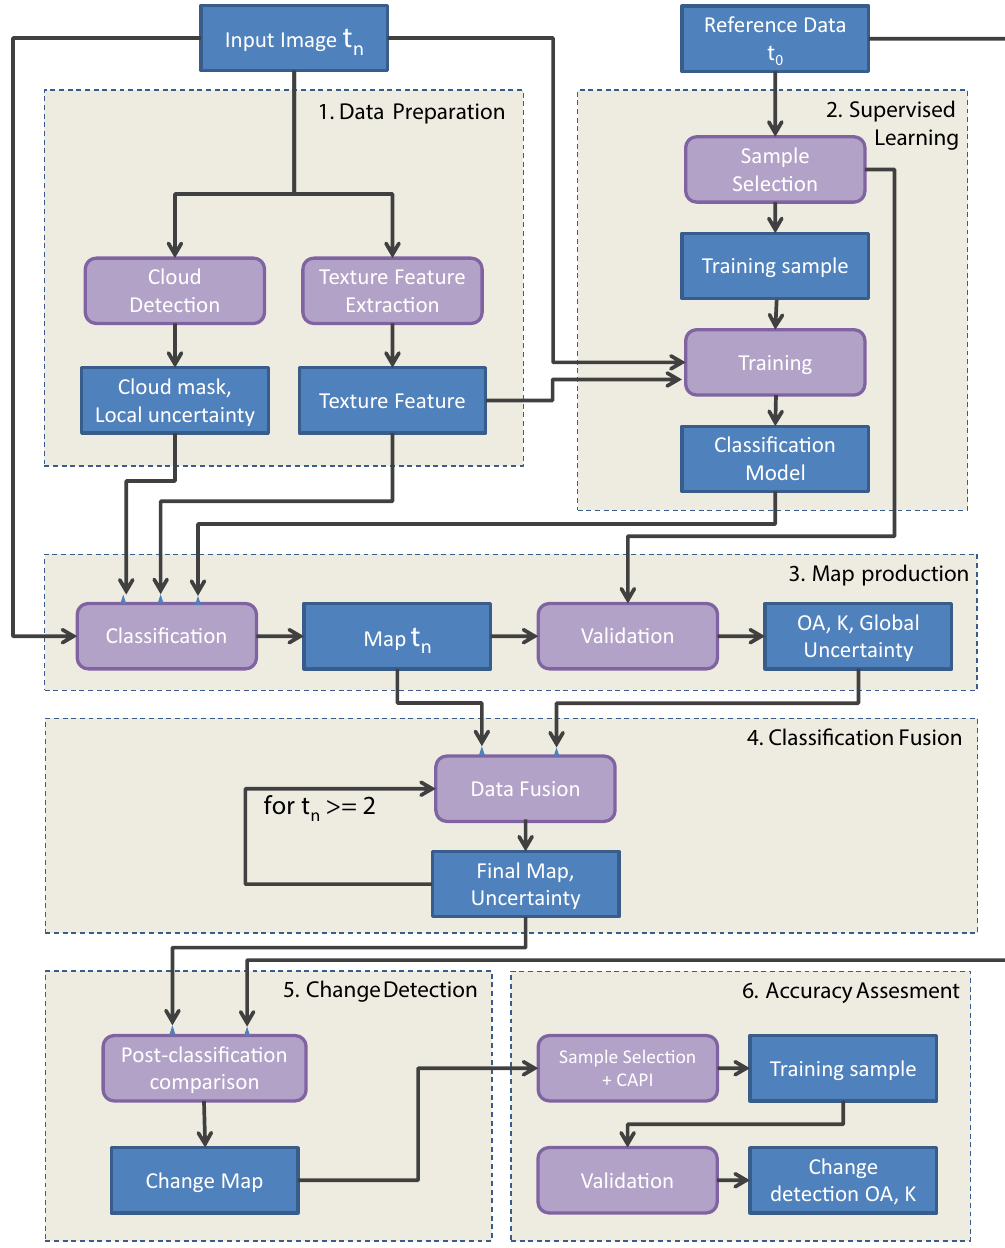
Figure 2. Block diagram of the workflow. Different time steps are noted t 0 ... t n ; OA stands for “Overall Accuracy”; K is the kappa index; CAPI stands for Computer-Assisted Photo